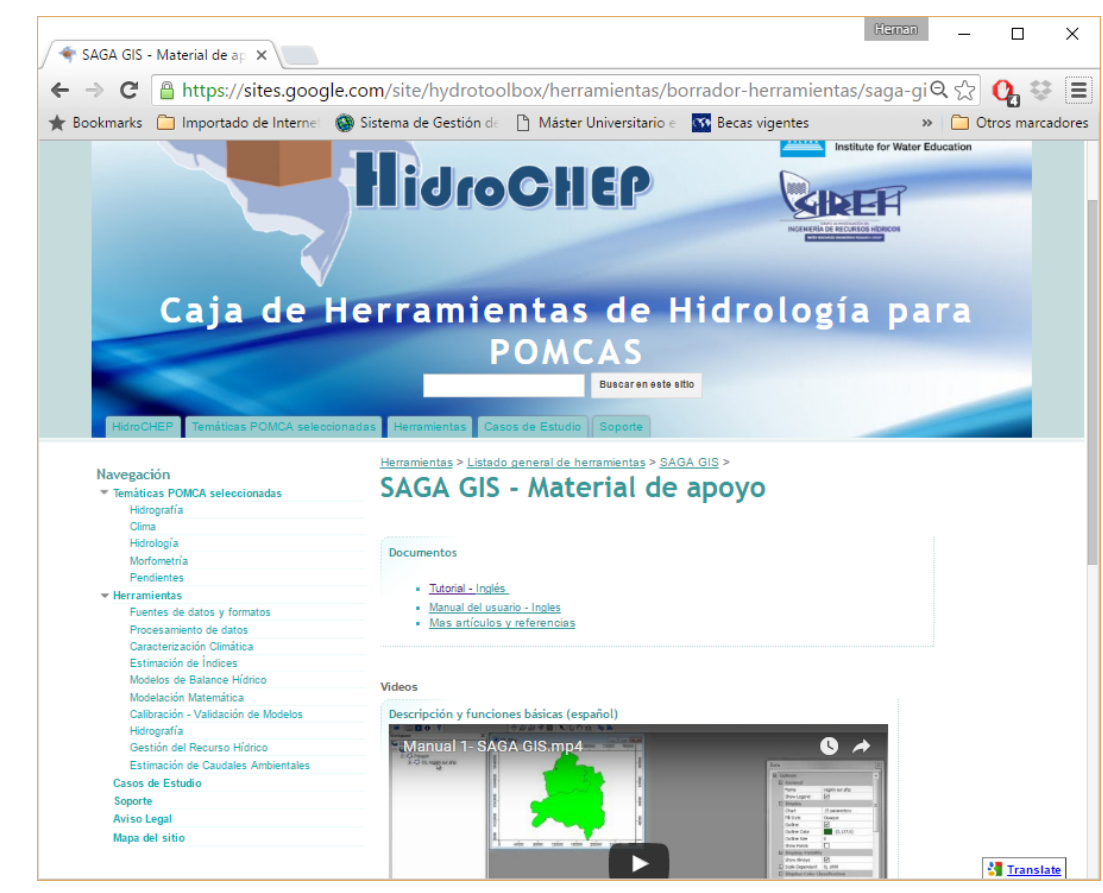
Figure 5. HidroCHEP interface showing the support material for the use of a